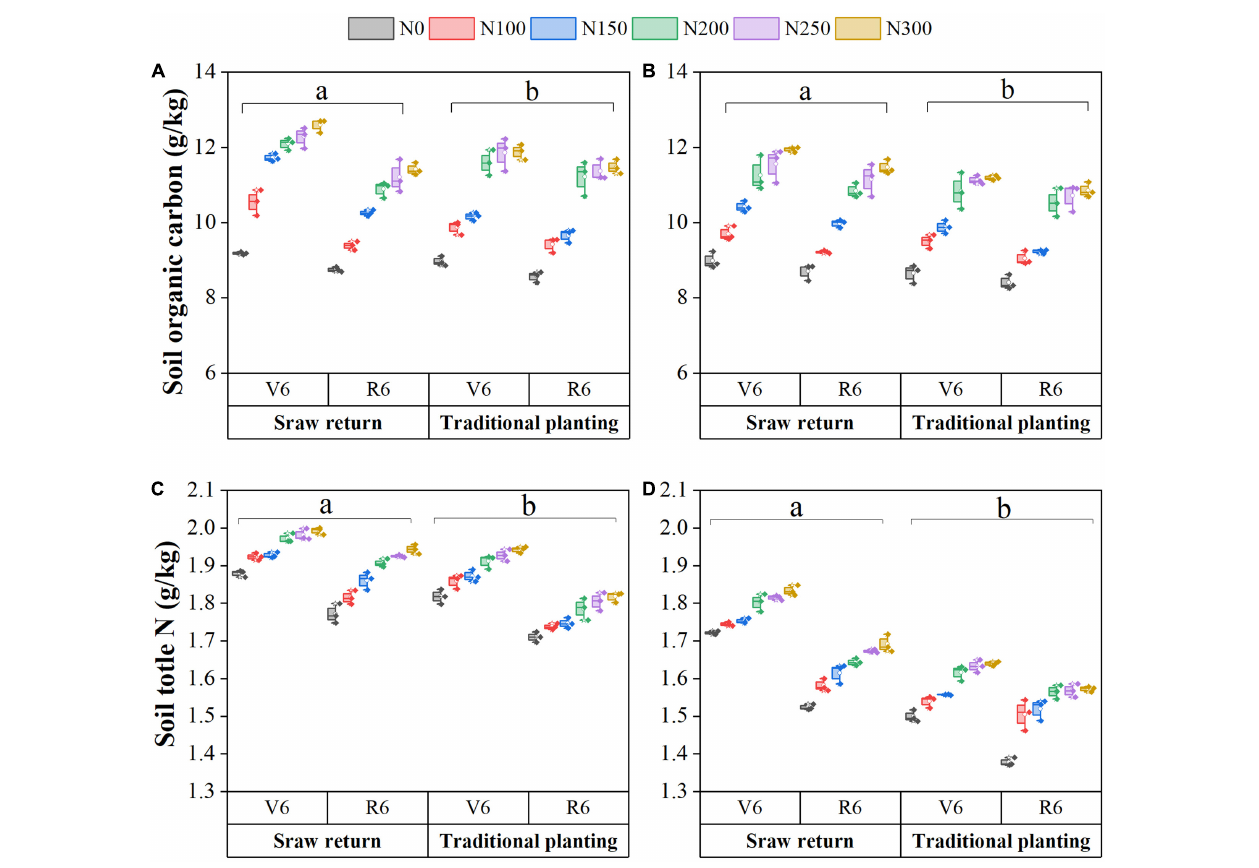
FIGURE 1 | Changes in soil physicochemical properties with straw returning and nitrogen fertilization under dual-cropping system. Soil organic carbon during spring (A) and autumn (B) , soil total nitrogen content in spring (C) and autumn (D)